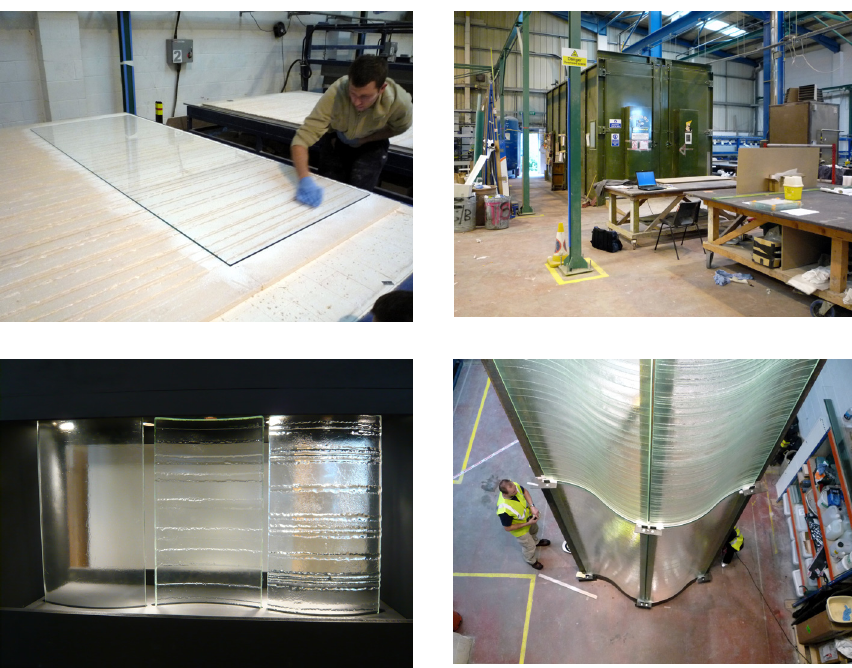
Figure 20a, b, c, d: Sand-bed Glass Texturing, Slumping Oven, Glass Samples, First Lighting Mock-up.